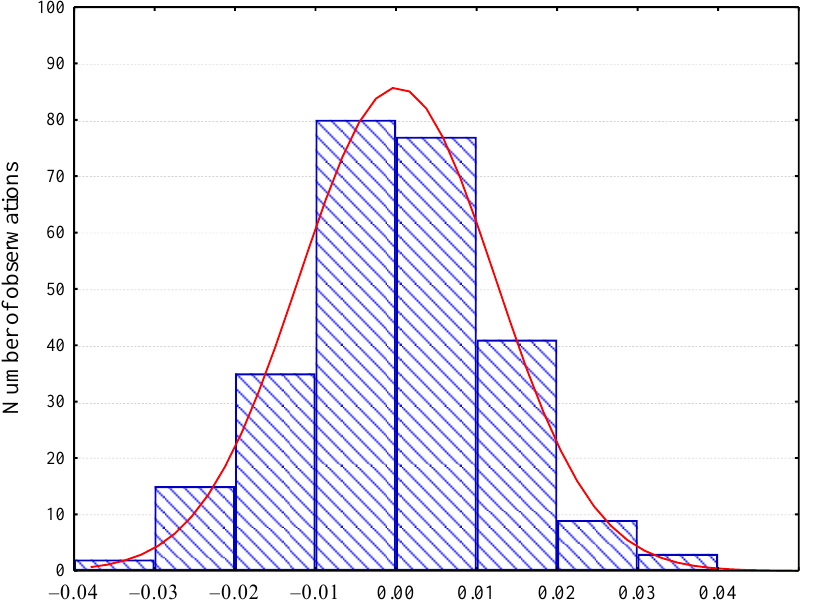
Figure 5. Distribution of residuals.